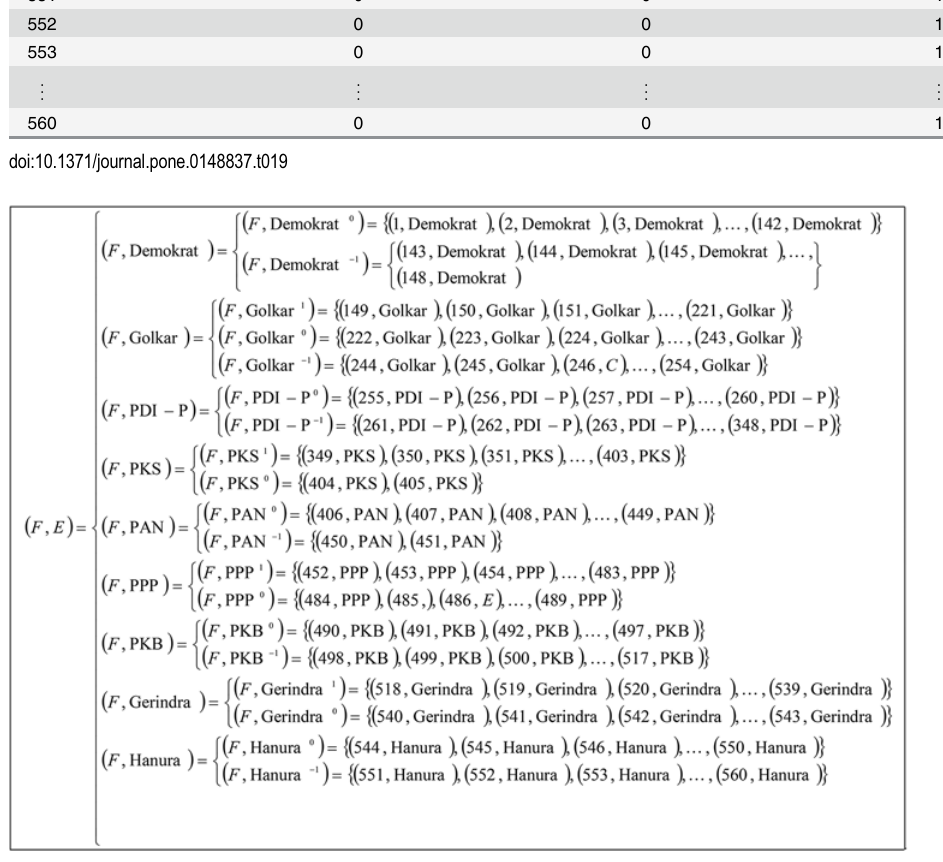
Fig 8. Multi-soft sets representing Indonesian parties voting (Tables 11 –